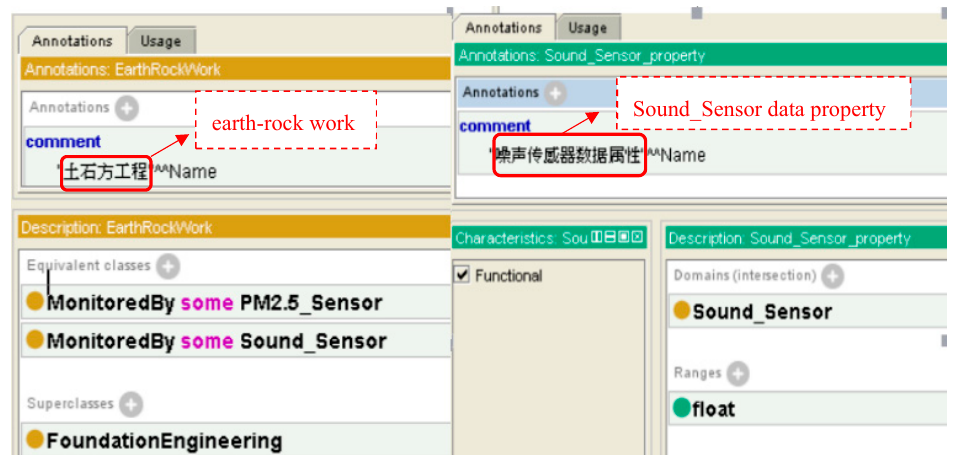
Figure 18. The sensor set in construction condition ontology.